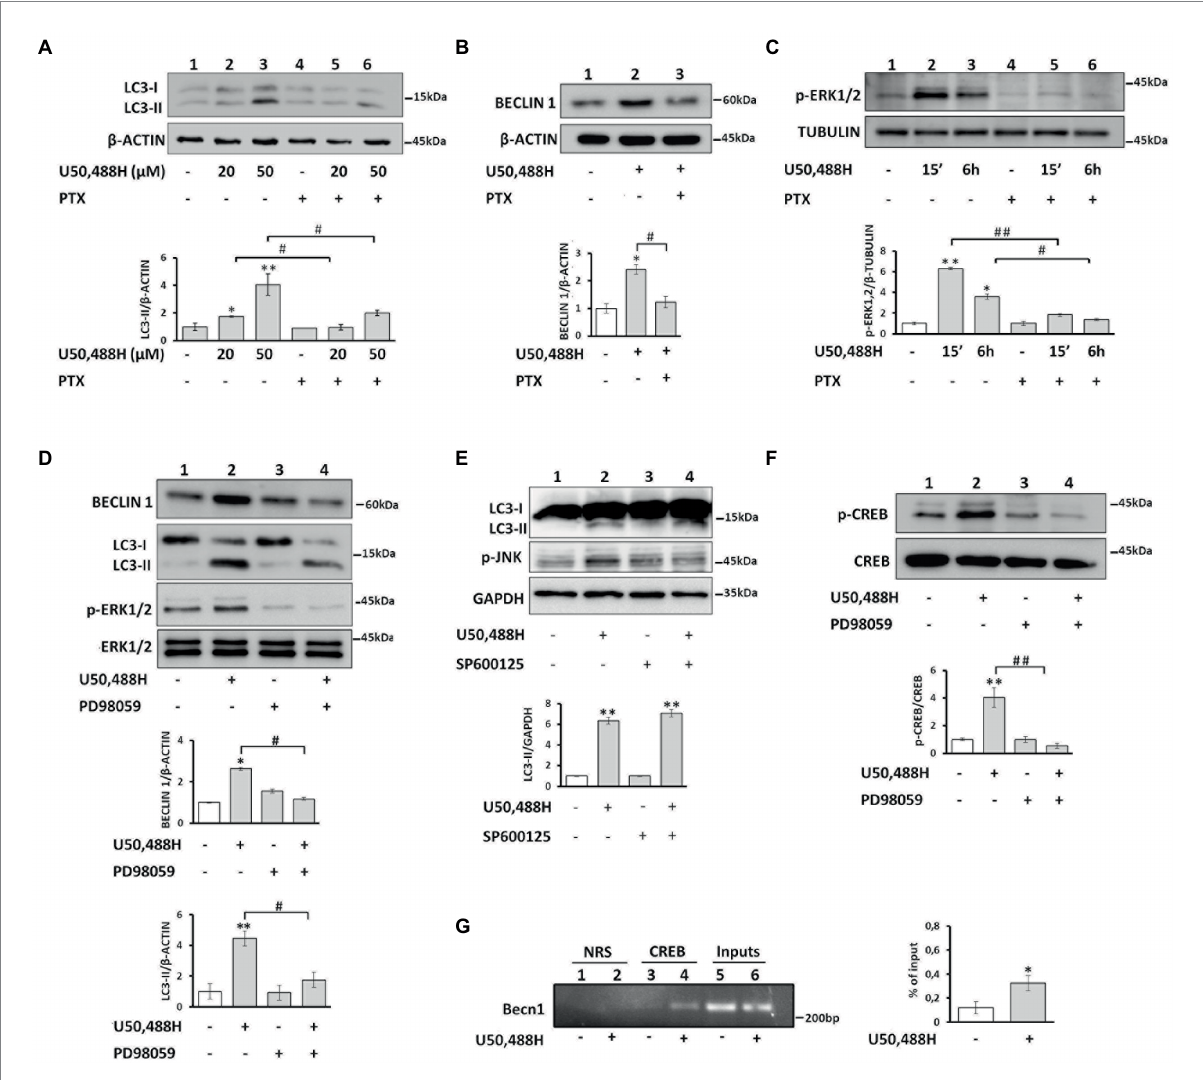
FIGURE 4 κ -OR activation induces autophagy in a G i/o protein, ERK 1,2 kinase and p-CREB dependent manner. (A) κ -Neuro-2A cells were pre-treated with PTX (100 ng/mL) for 16 h, followed exposure to U50,488H for 6 h and LC3-II levels were assessed by Western immunoblotting. β -actin was used as loading control. Error bars represent mean values±SEM; Statistical analyses were performed using two-way ANOVA; * p < 0.05 and ** p < 0.01 as compared to the untreated samples; # p < 0.05 as compared to U50,488H treated samples. (B) Beclin 1 levels were detected after PTX pre-treatment following administration with 20 μΜ U50,488H for 6 h. β -actin was used as loading control. Error bars represent mean values±SEM; two-way ANOVA was performed. * p < 0.05 as compared to the untreated samples and # p < 0.05 as compared to treated samples. (C) κ -Neuro2A cells were pre-treated with PTX for 16 h, prior to U50,488H (20 μΜ ) for 15 min and 6 h exposure and the levels of p-ERK1,2 were quantified. Tubulin was used as loading control. Error bars represent mean values ± SEM. Two-way ANOVA was performed with * p < 0.05 and ** p < 0.01 as compared to the untreated samples; # p < 0.05 and ## p < 0.01 as compared to U50,488H treated samples. (D) κ -Neuro-2A cells were pre-treated with the ERK1,2 inhibitor PD98059 (20 μΜ ) for 2 h, followed by U50,488H (20 μΜ ) administration for 6 h. Total ERK1,2 was used for quantification. Error bars represent mean values ± SEM. Statistical analyses were performed using two-way ANOVA. * p < 0.05 and ** p < 0.01 as compared with untreated cells; # p < 0.05 as compared with samples in the presence of U50,488H. (E) The levels of p-JNK were estimated in κ -Neuro-2A cells in the presence or not of the JNK inhibitor SP600125 (20 μΜ ) for 30 min prior to 6 h U50,488H (20 μΜ ) administration. All experiments were performed three times. GAPDH was used as loading control. Error bars represent mean values ± SEM. Statistical analyses were performed using two-way ANOVA. **p < 0.01 as compared with untreated cells. (F) κ -Neuro-2A cells were pre-treated with or without PD98059 (20 μΜ ) for 2 h, followed by U50,488H (20 μΜ ) exposure for 6 h. The phosphorylated levels of CREB were analyzed by Western blotting using an anti-p-CREB (Ser133) (1:500) serum and normalized to total CREB using a specific antibody (1:1000). Statistical analysis was performed using two-way ANOVA. ** p < 0.01 as compared with untreated samples and ## p < 0.01 as compared with samples in the presence of U50,488H. (G) Chromatin immunoprecipitation was performed in κ -Neuro-2A cells as described in Materials and methods using an anti-CREB (10 μ g) (lanes 3, 4) or normal rabbit serum (NRS) (lanes 1, 2). Immunoprecipitated Becn1 promoter region was amplified by PCR and the densitometry of the bands was quantified by Image J software on an agarose gel. CREB immunoprecipitated chromatin from control and U50,488H treated samples were normalized to their respective inputs. Error bars represent mean ± SEM of three independent experiments. Statistical analysis was performed using one-way ANOVA. * p < 0.05 as compared with untreated